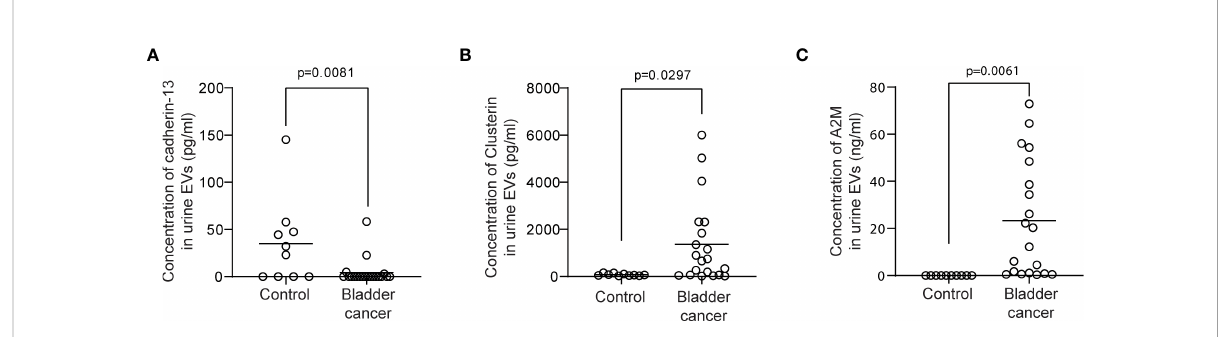
FIGURE 4 ELISA for clusterin, cadherin-13, and a2M in uEVs from non-cancer controls and BC patients. uEVs (0.5 m g/well) from 10 non-cancer controls and 20 BC patients were applied to ELISA for clusterin (A) , cadherin-13 (B) , and a2M (C) . Mean values of each group were indicated as lines.